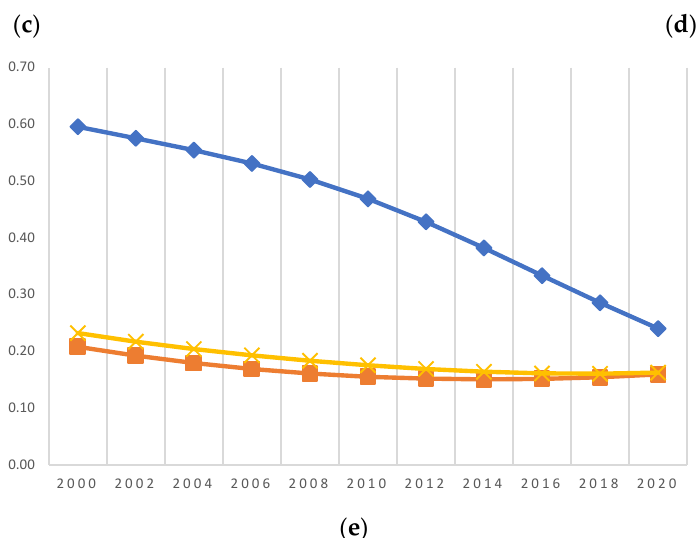
Figure 2. Visualization of energy efficiency economic indicators σ -convergence assessment. Note: ( a ) at the minimum wage; ( b ) current expenditures on environmental protection; ( c ) at the cost of electricity; ( d ) at the cost of natural gas; ( e ) by the share of household expenditures on housing and utilities; The ordinate axis is units; abscissa — years; blue line — Ukraine, orange line — EU countries, yellow line — Ukraine and EU countries.